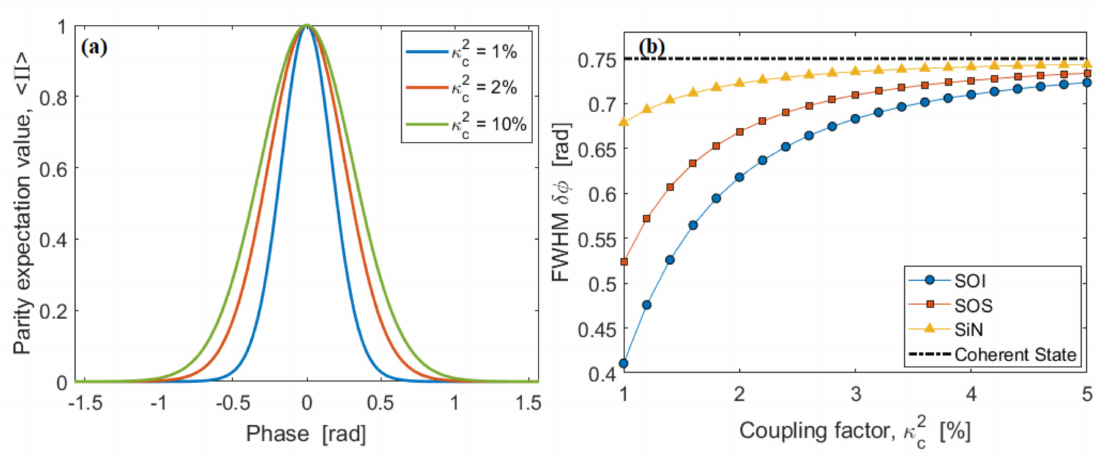
Figure 6. ( a ) Parity expectation value, (cid:104) Π (cid:105) , as a function of the phase ϕ , for di ff erent values of the coupling factor, κ 2 c , assuming SOI platform, N = 10 L = 100 µ m, and P 0 = 0.4 mW; ( b ) Resolution ( δϕ ) as a function of the coupling factor, κ 2 c , for SOI, SOS, and SiN platforms, respectively, assuming N = 10 and L = 100 µ m. The dashed-dot black line represents the value for coherent state